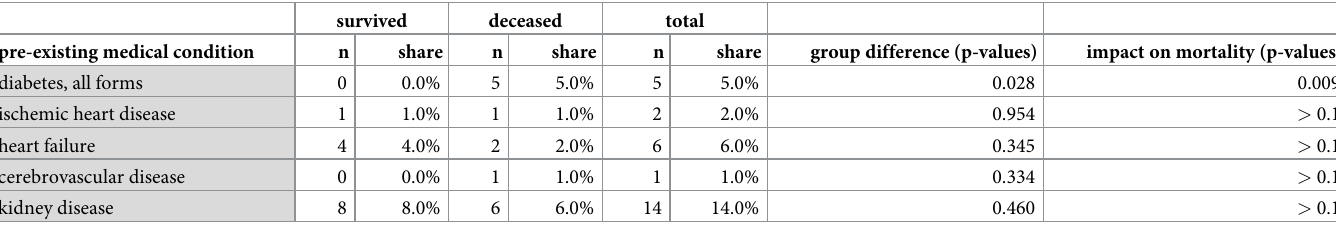
Table 2. Medical